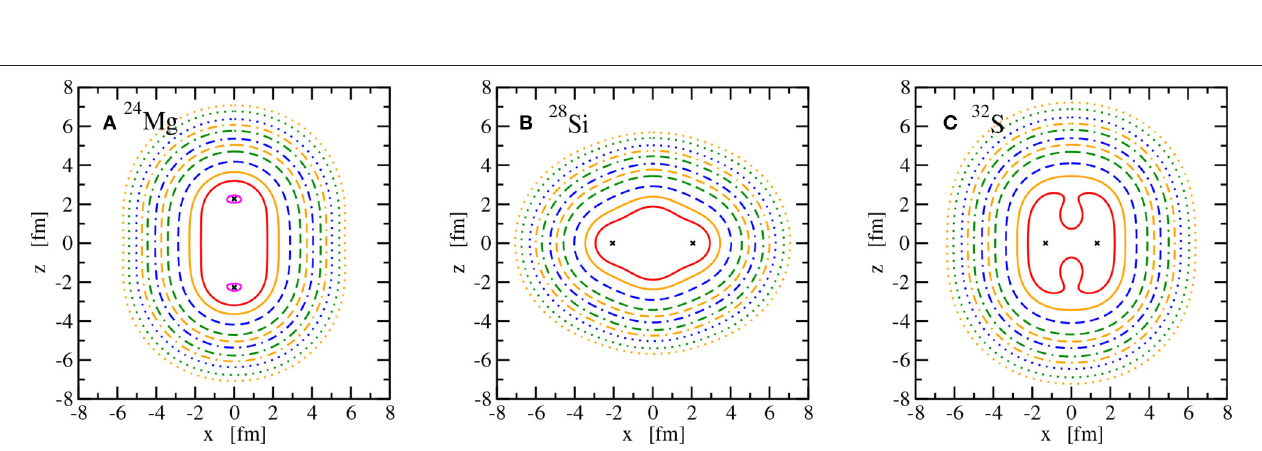
FIGURE 9 | Lines of constant intrinsic matter density ρ of the nuclei 12 C (A) , 16 O (B) , and 20 Ne (C) . See Figure 8 for the legend. Points of maximum density are indicated with a or a full black line in case of 16 O. ×